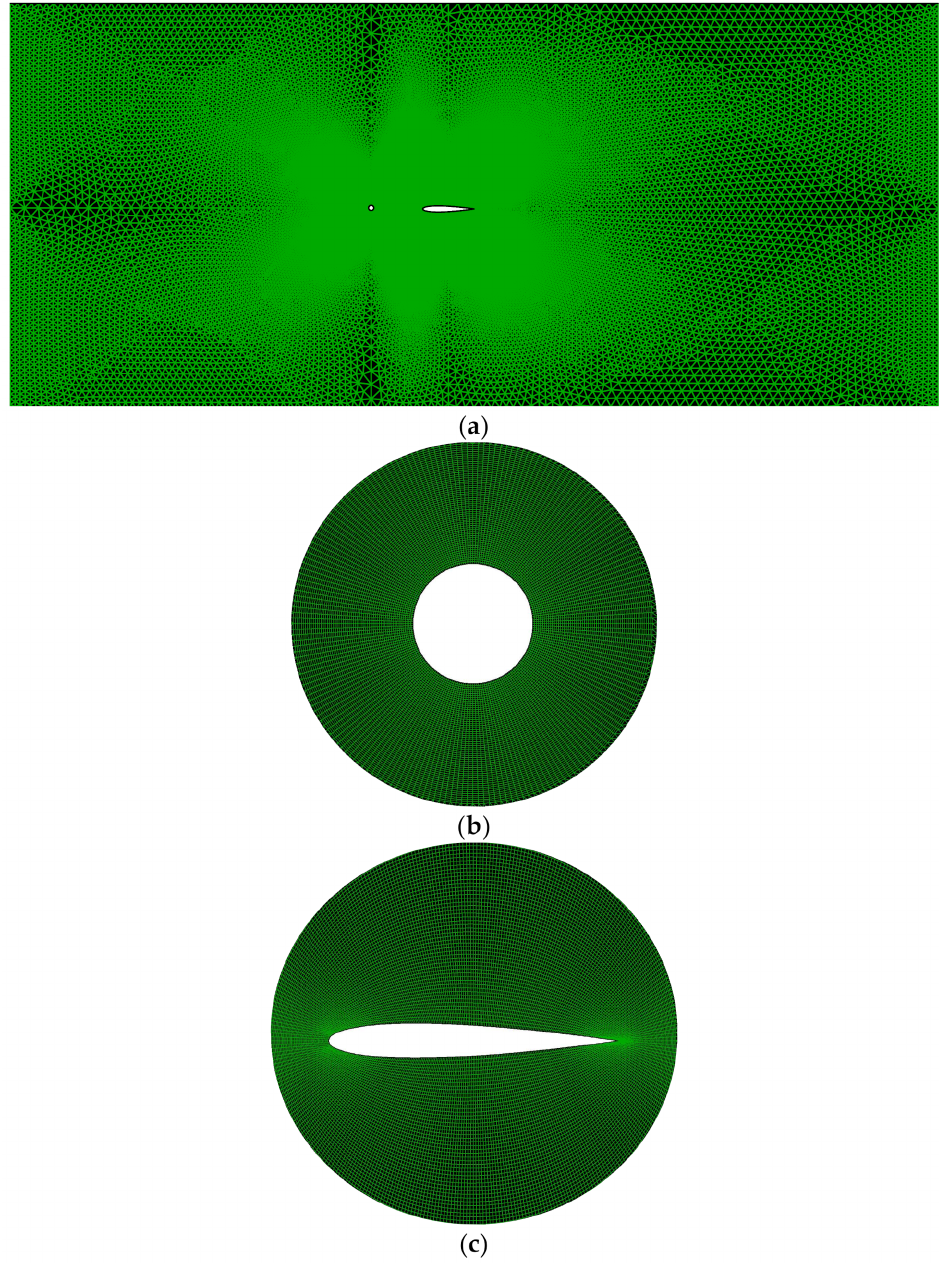
Figure 2. The solution field meshing in wide and close-up views: ( a ) meshing in a wide view of the solution field, ( b ) close-up on the meshing around the rod, ( c ) close-up on the meshing around the